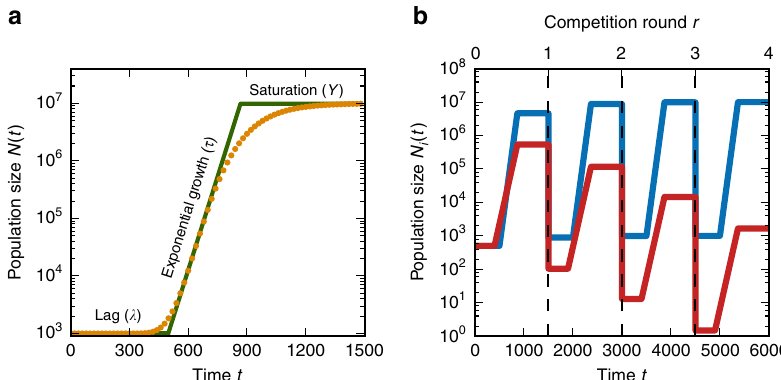
Fig. 1 Model of growth and competition. a Approximation of a hypothetical growth curve (orange points) by the minimal three-phase model (green; see 'Methods'). Each phase is characterized by a quantitative trait: lag time λ , growth time τ (reciprocal growth rate), and yield Y at saturation. b Growth curves of two competing strains over multiple rounds of competition in the model. Vertical dashed lines mark the beginning of each round, where the population is diluted down to the same initial population size with new resources ('Methods')